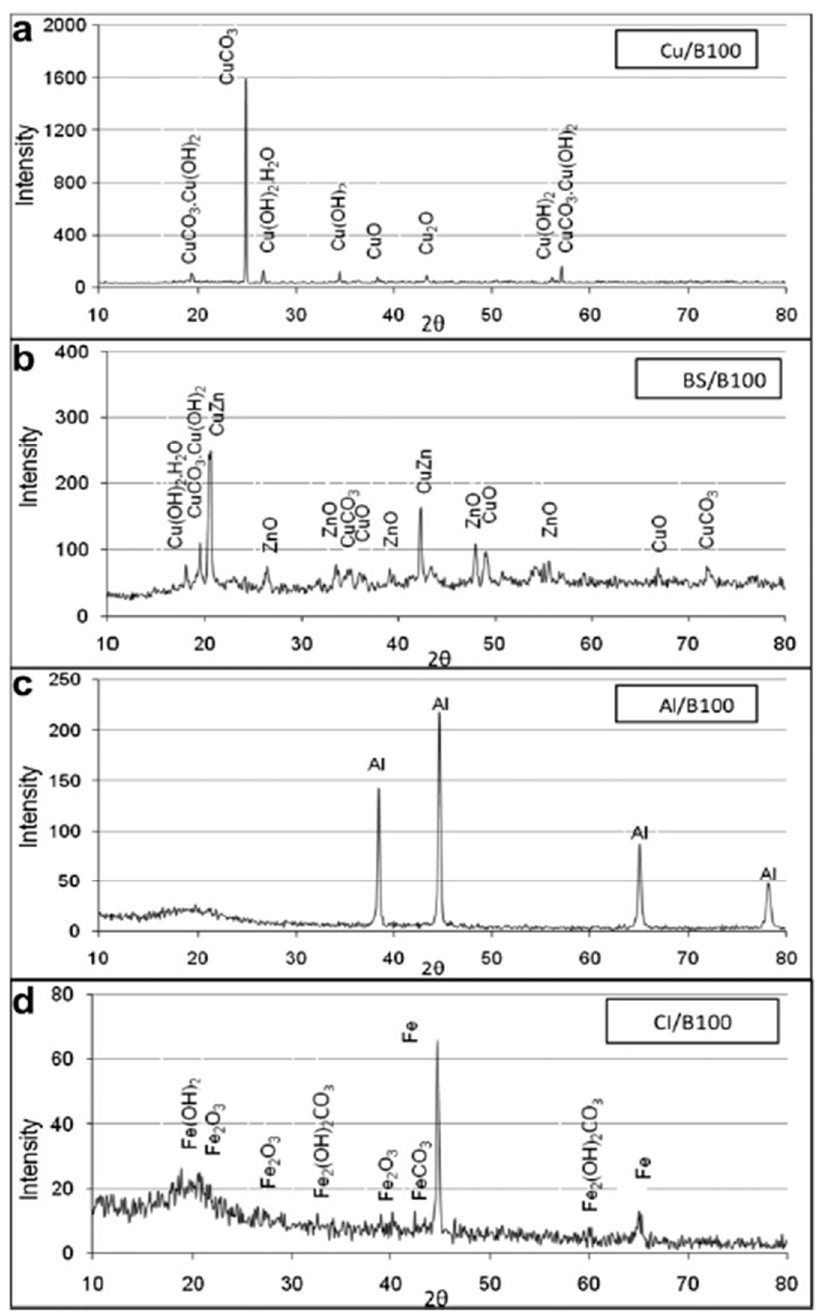
Figure 15. ( i ) Products of corrosion formed on as ‐ received materials and B0 and B100 blends [64]. ( ii ) Products of corrosion formed on as ‐ received materials and B0 and B100 blends [64].